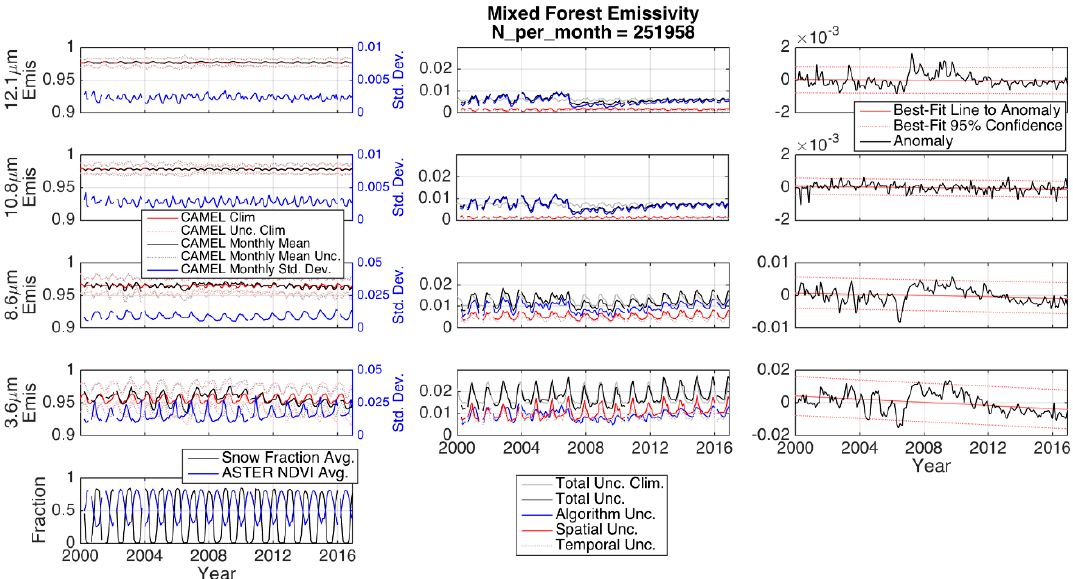
Figure 8. Time series for the IGBP Mixed Forest land classification category of CAMEL ( left ) monthly and climatological emissivity (black and red) and standard deviation of the monthly CAMEL emissivity over the IGBP category (blue), ( middle ) the CAMEL monthly and climatological uncertainty, and ( right ) the CAMEL monthly emissivity anomalies with a best fit line. Bottom row shows the ( bottom , left ) monthly snow fraction and NDVI. The number of samples per month is 251,958.